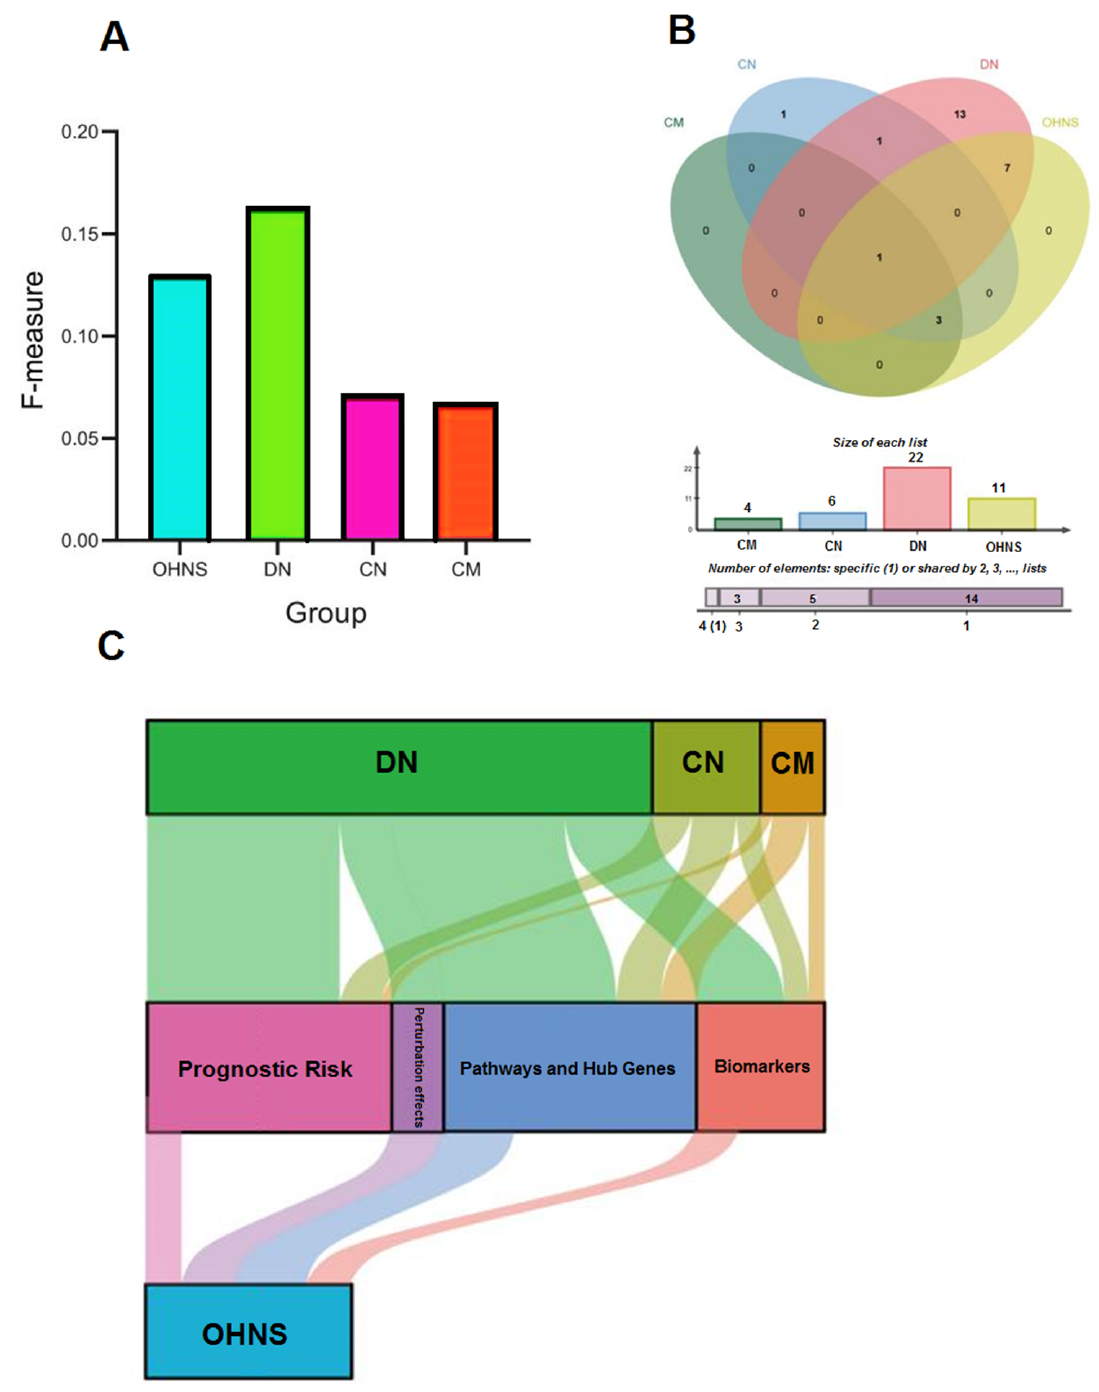
Figure 4. Correlation and F-measure: ( A ) the F-measure of genes overlapping with CM (core module), CN (core nodes), DN (driver nodes), and the OHNS in the CTD list; ( B ) comparison of the overlapping genes with CM, CN, DN, and OHNS in the CTD list; ( C ) comparison of distributions of CM, CN, DN, and OHNS in biomarkers, pathway and hub genes, risk-prognostic genes, and perturbation effects. The width of the extended branch in the figure corresponds to the data flow size.